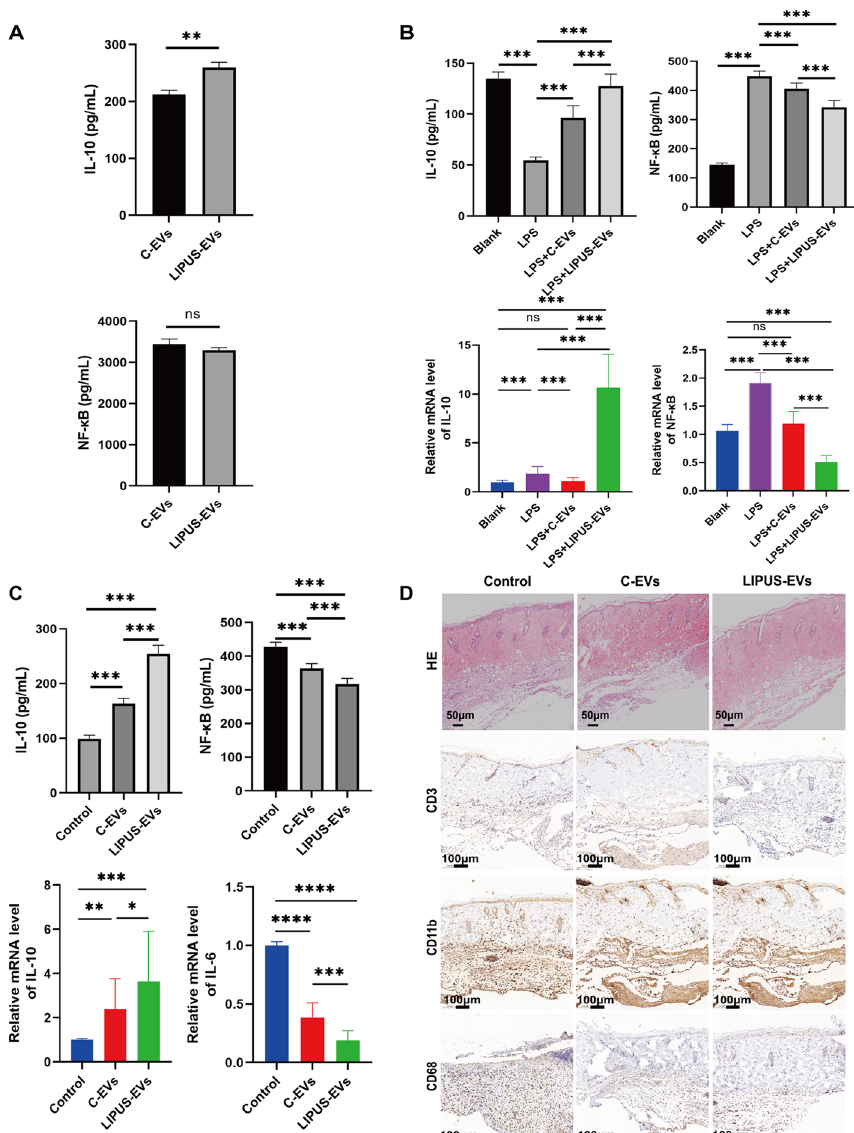
Fig. 3 LIPUS strengthened the anti-inflammatory effect of BMSCs-derived EVs. A The protein expression levels of pro-inflammatory cytokines (IL-10 and NF-κB) in both C-EVs and LIPUS-EVs detected by ELISA assay ( n 6 per group). B The protein expression of IL-10 and NF-κB in RAW264.7 cells measured by ELISA. And the = mRNA level of IL-10 and NF-κB in RAW264.7 cells by qRT-PCR. ( n 6 per group). C The protein expression of = IL-10 and NF-κB in skin allografts measured by ELISA. The mRNA expression of IL-10 and IL-6 in skin allografts measured by qRT-PCR. ( n 4 per group). D H&E-stained sections of skin allograft. Scale bar 50 μm. = = Immunohistochemistry staining of the skin allograft in control group contained massive infiltrates of CD3 + , CD11b + and CD68 + cells in comparison to the C-EVs and LIPUS-EVs group. (Representative images from 3 different mice per group). Scale bar 100 μm. Error bars represent mean SD. ns p > 0.05, * p < 0.05, ** p < 0.01, = ± *** p < 0.001. Statistical significance assessed by unpaired two-tailed t -test. EVs, extracellular